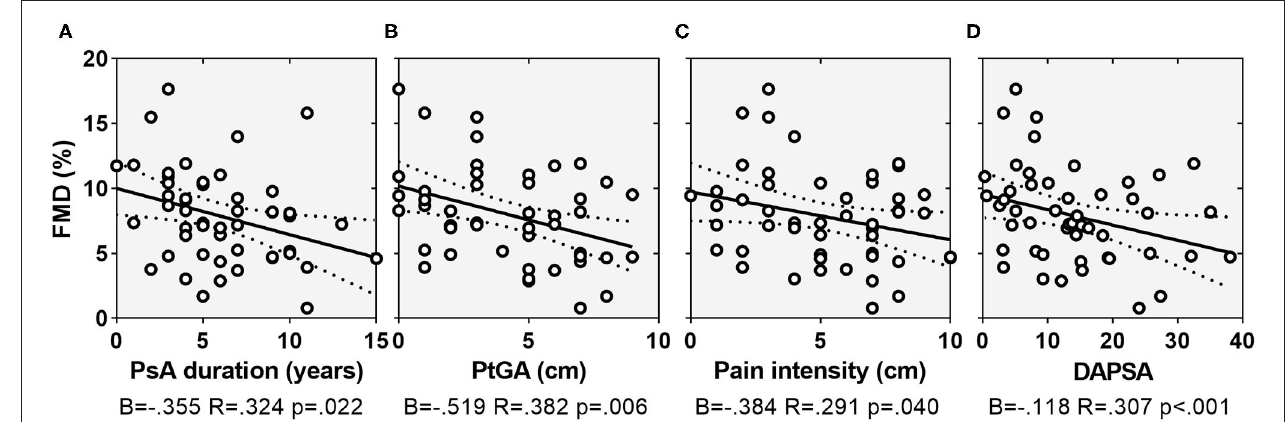
FIGURE 2 | Scatterplots showing the relationship between FMD and PsA duration (A) , PtGA (B) , pain intensity on VAS (C) , and DAPSA (D) . Dotted lines indicate 95% confidence interval. FMD, flow-mediated dilation; PsA, psoriatic arthritis; PtGA, patient global assessment; VAS, visual analog scale; DAPSA, disease activity in psoriatic arthritis.